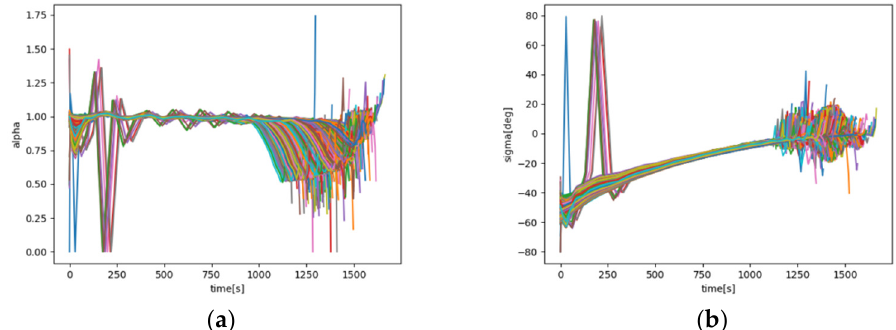
Figure 4. Control of training data. ( a ) Generalized lift coefficient–time curve; ( b ) Heeling Angle– time curve.